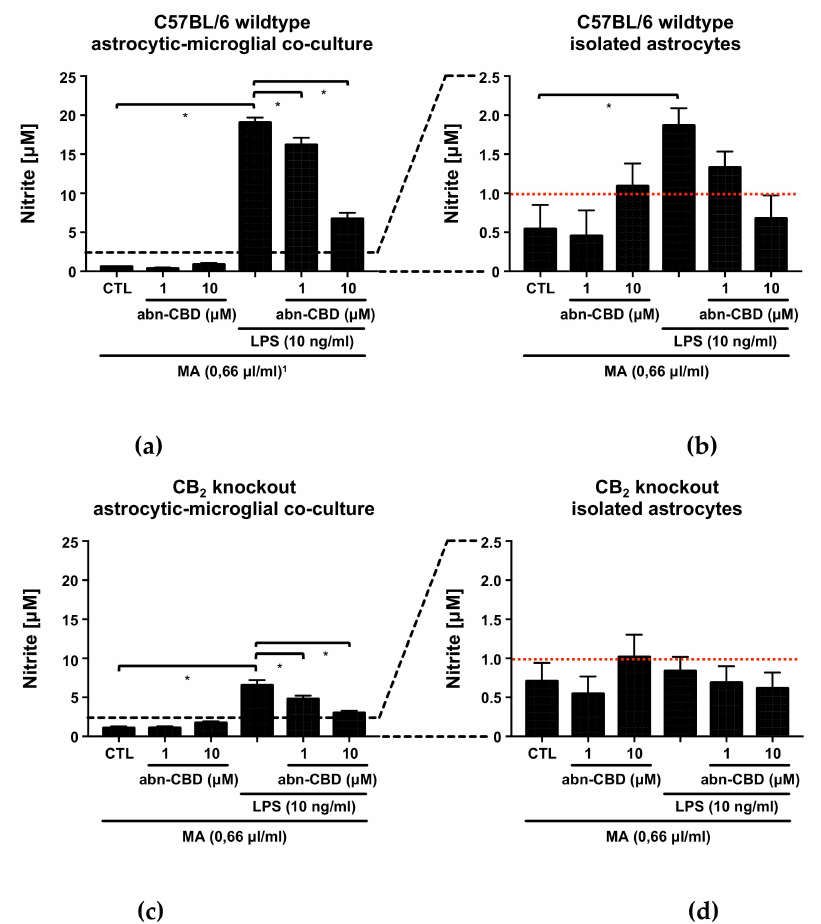
Figure 1. Nitrite measurement in supernatants from astrocytic-microglial cocultures ( a , c ) and isolated astrocytes ( b , d ) from C57BL / 6 wildtype ( a , b ) and CB 2 knockout mice ( c , d ). Data is expressed as mean ± standard error of the mean (SEM), n = 12 in each group. Statistical analysis was done using one-way analysis of variance (ANOVA) followed by Bonferroni’s post-test. * p < 0.05. Note the di ff erent scaling of the y -axis between cocultures ( a , c ) and isolated astrocytes ( b , d ). The lower detection limit of the assay, as given by the manufacturer and estimated on basis of the standard curve, is shown by the red dotted line. 1 All groups received the same concentration (0.66 µ L / mL) of the solvent methylacetate (MA) as contained in 10 µ M abn-CBD